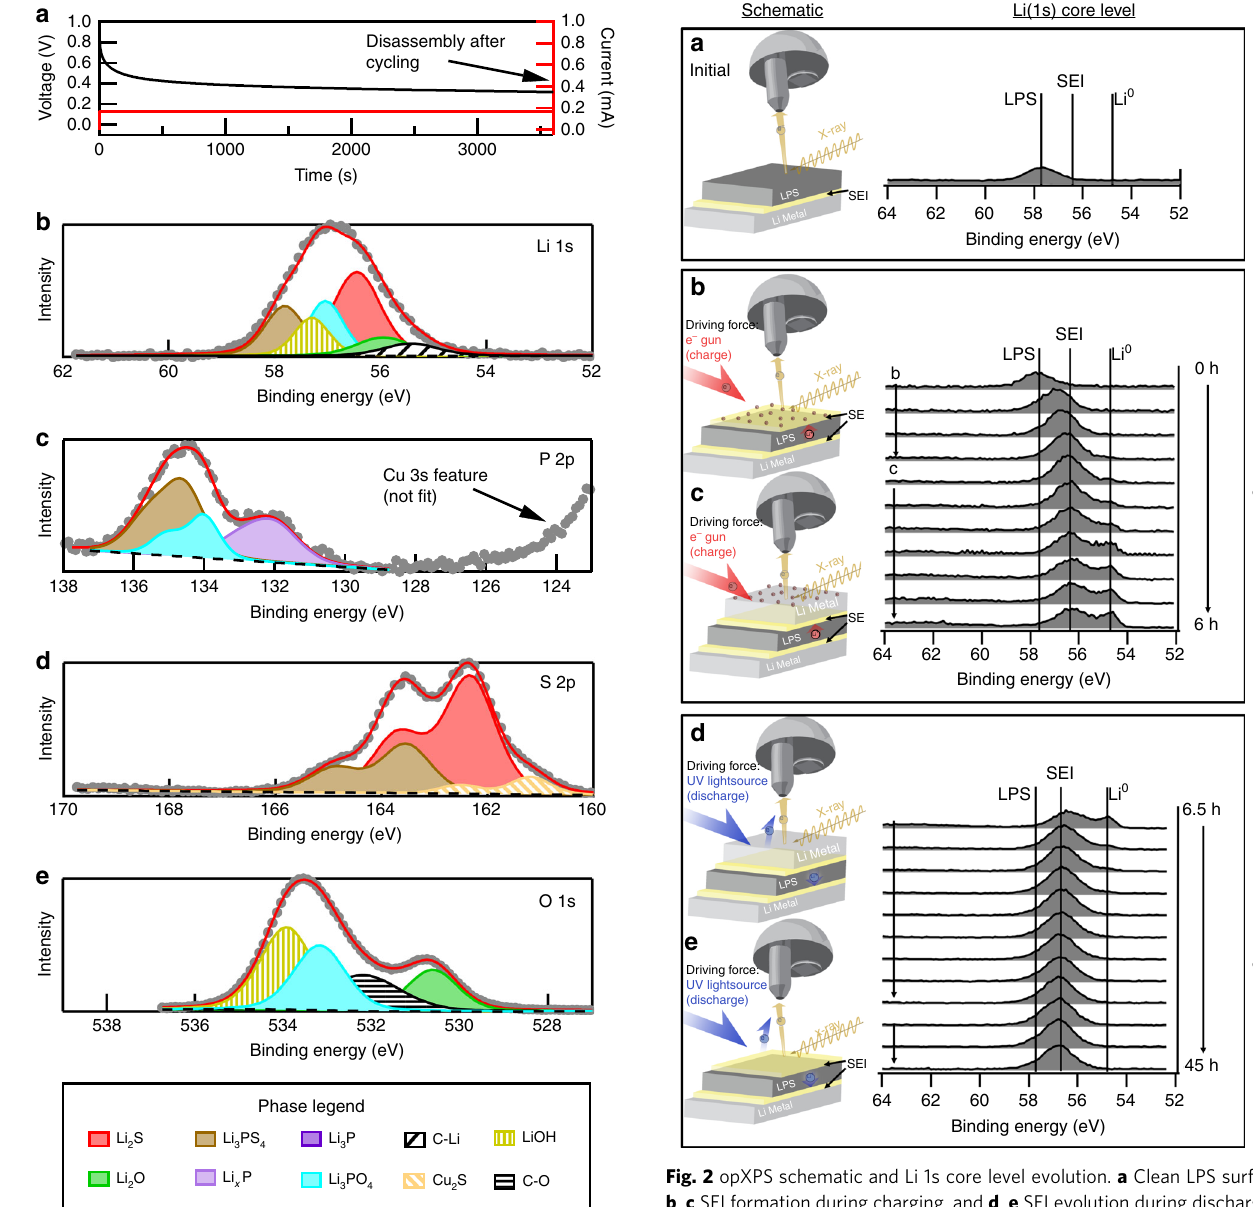
Fig. 1 Ex situ XPS spectral decomposition of Li/LPS SEI. a Galvanostatic voltage pro fi le of Cu/LPS/Li coin cell during initial charging. The cell was disassembled after 1.5 h of Li deposition onto the Cu electrode. Ex situ XPS spectra are shown for the Li 1s ( b ), P 2p ( c ), S 2p ( d ), and O 1s ( e ) core